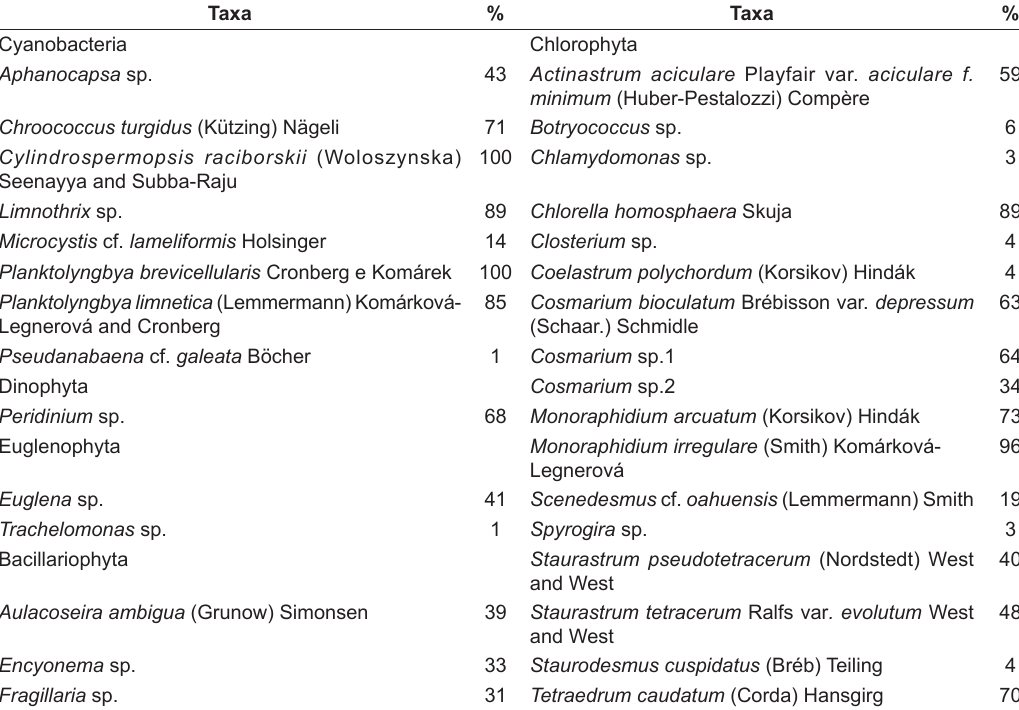
Table 2. Phytoplanktonic species and frequency of occurrence (%) observed in Peri Lake, from June/09 to January/11. Taxa % Taxa % Cyanobacteria